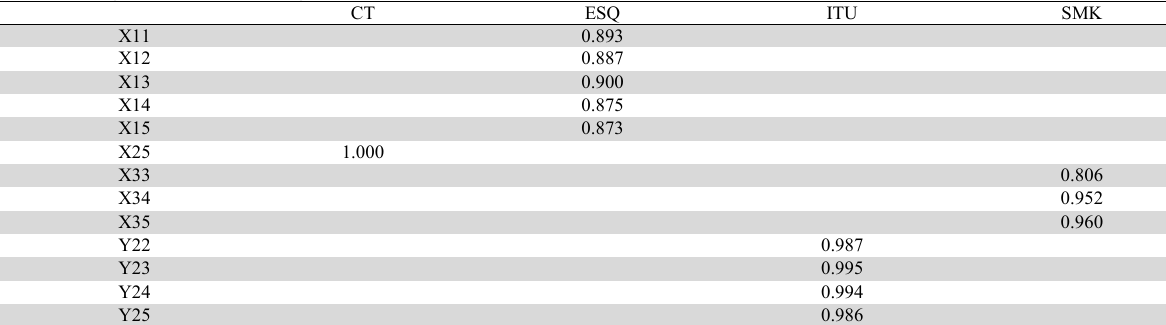
Item Loading and Cross-Loading